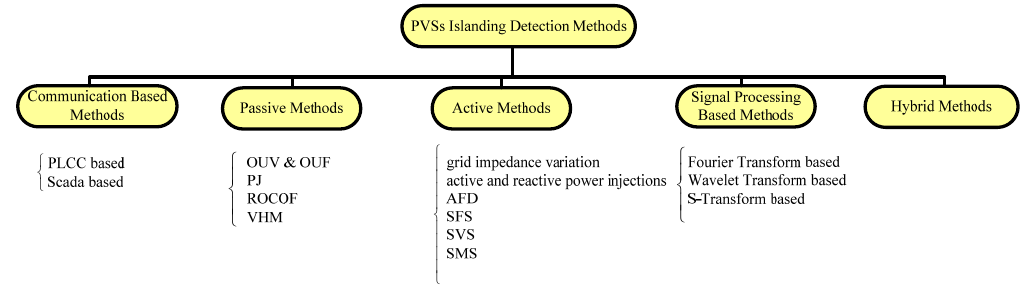
Figure 9. PVSs islanding detection methods classification.